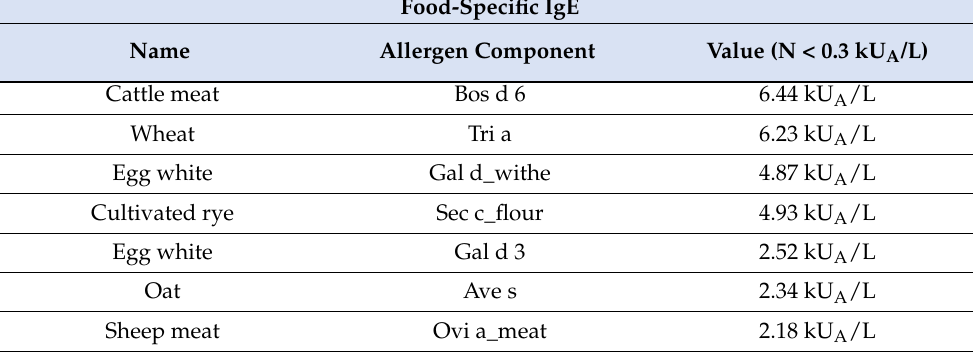
Table 2. Summary report of increased serum specific IgE reproduced from Allergy Explorer Test (2019) (ELISA multiplex method, Macro array